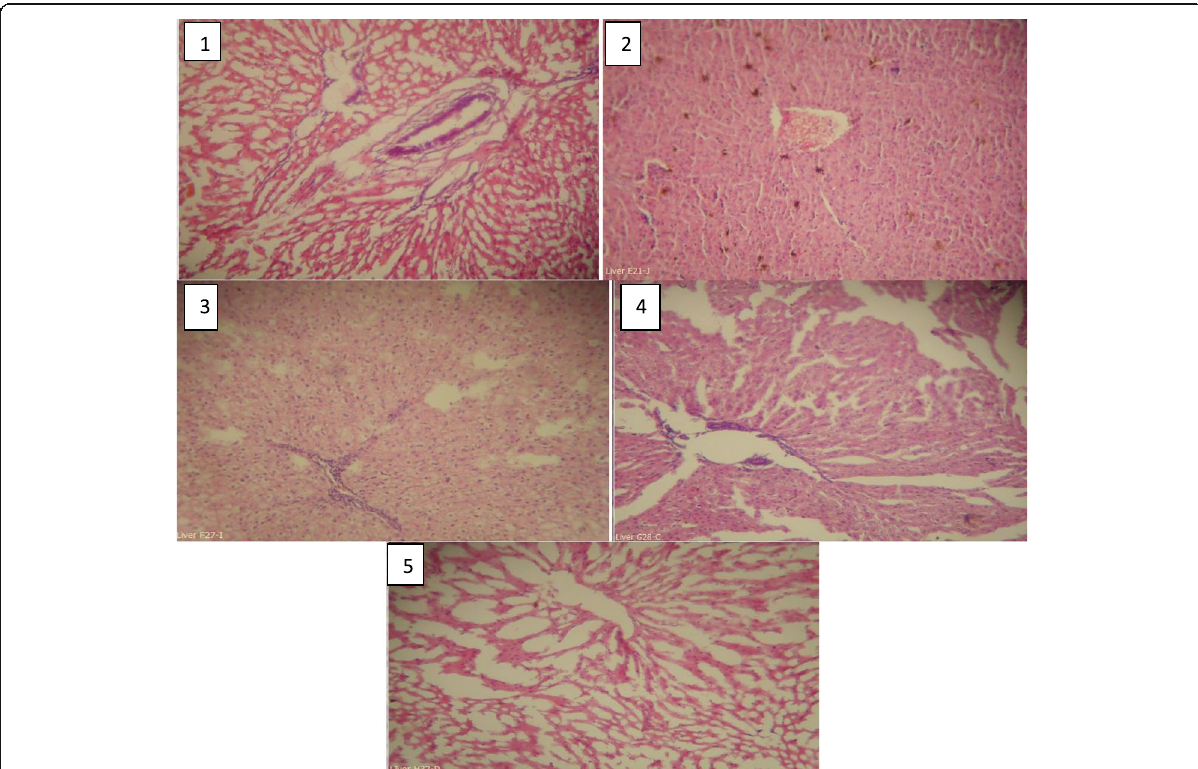
Fig. 1 Histological Sections of the Liver. Plate 1 : Group (1): given continuous salt-load. There is periportal inflammation and mild vacuolation of the hepatocytes. Plate 2 : Group (2): given salt-load and treated with aqueous extract. There is shrinking of the portal vein and granulation of hepatocytes Plate 3 :. Group (3): given salt-load and treated with ethanolic extract. There is infiltration and congestion of the porta vein as well as granulation of hepatocytes Plate 4 : Group (4): given salt-load and distilled water. There is periportal inflammation and mild vacuolation of the hepatocytes. Plate 5 : Control Group (5): given distilled water. The central portal vein appears